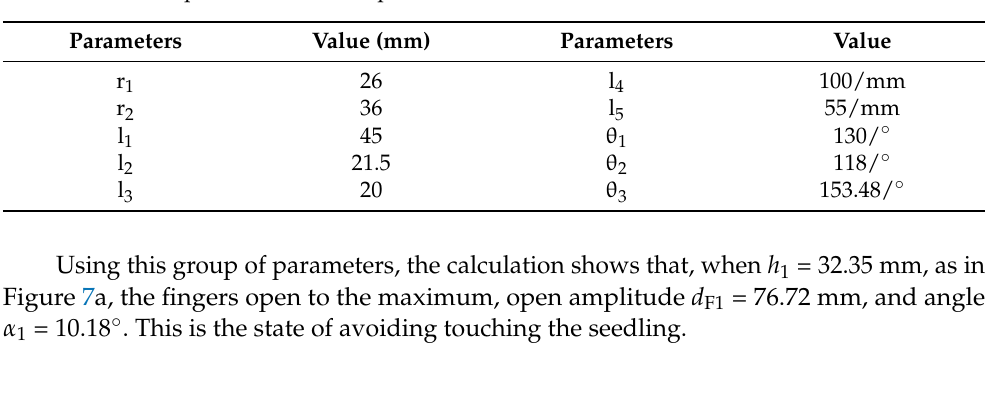
Table 1. Structure parameters of manipulator